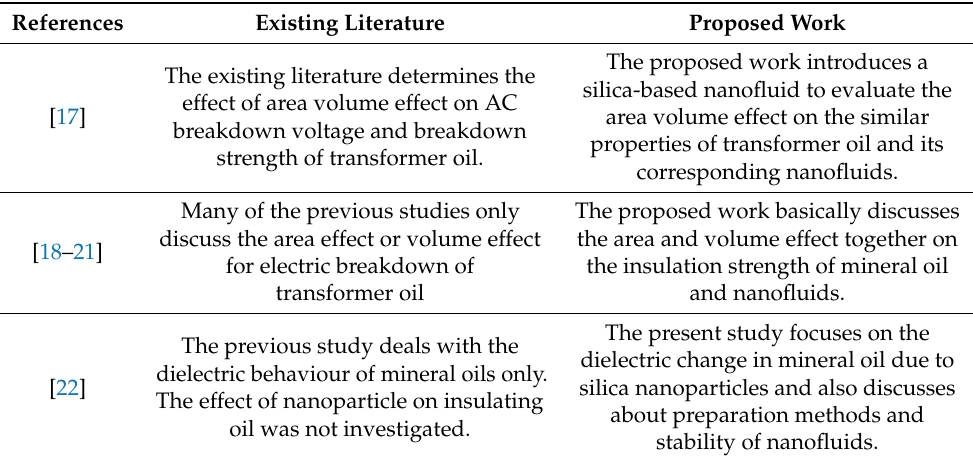
Table 1. Comparison table of the existing literature on dielectric behaviour of transformer oil with the proposed